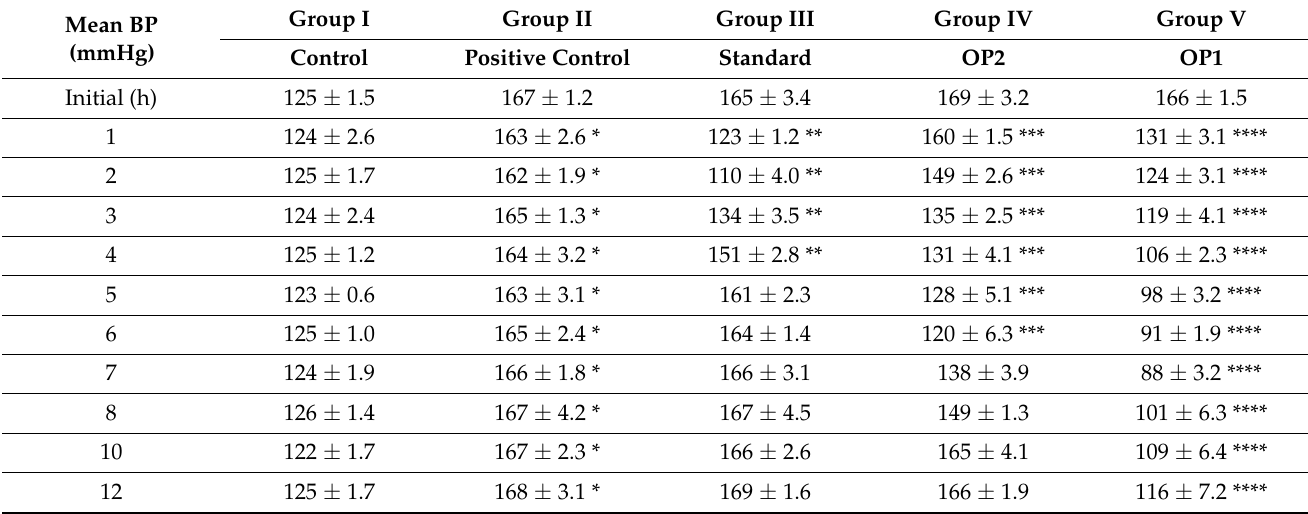
Table 11. Antihypertensive effect of optimized TEL-loaded beads (OP1 and OP2) in hypertension- induced rats.